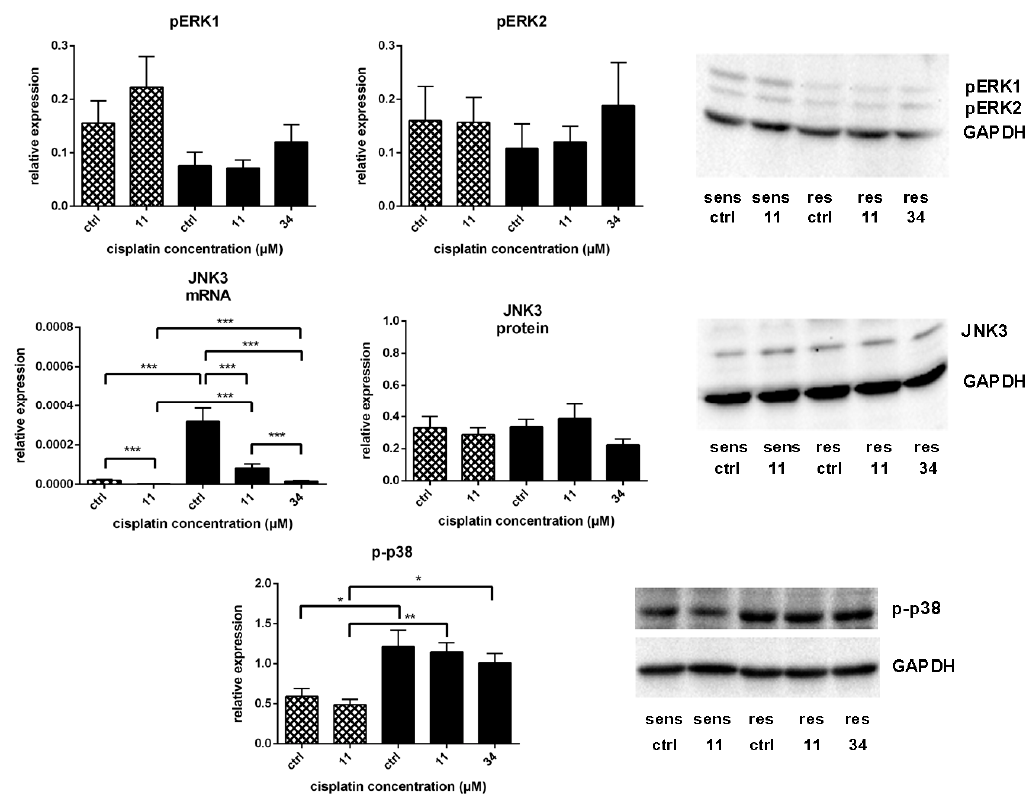
Figure 5. Expression of activated ERK (pERK1 and pERK2, both n = 7) related to GAPDH expression; mRNA expression of JNK3 ( n = 6) related to GAPDH mRNA expression; protein expression of JNK3 ( n = 9) related to GAPDH expression; expression of activated p38 (p-p38, n = 4) related to GAPDH expression in A549 ( ) and A549 r CDDP 2000 ( ) after treatment with 11 µM cisplatin (11) or 34 µM cisplatin (34) expressed as mean ± SEM, as well as representative Western blots.* p < 0.05; ** p < 0.01; *** p < 0.01.